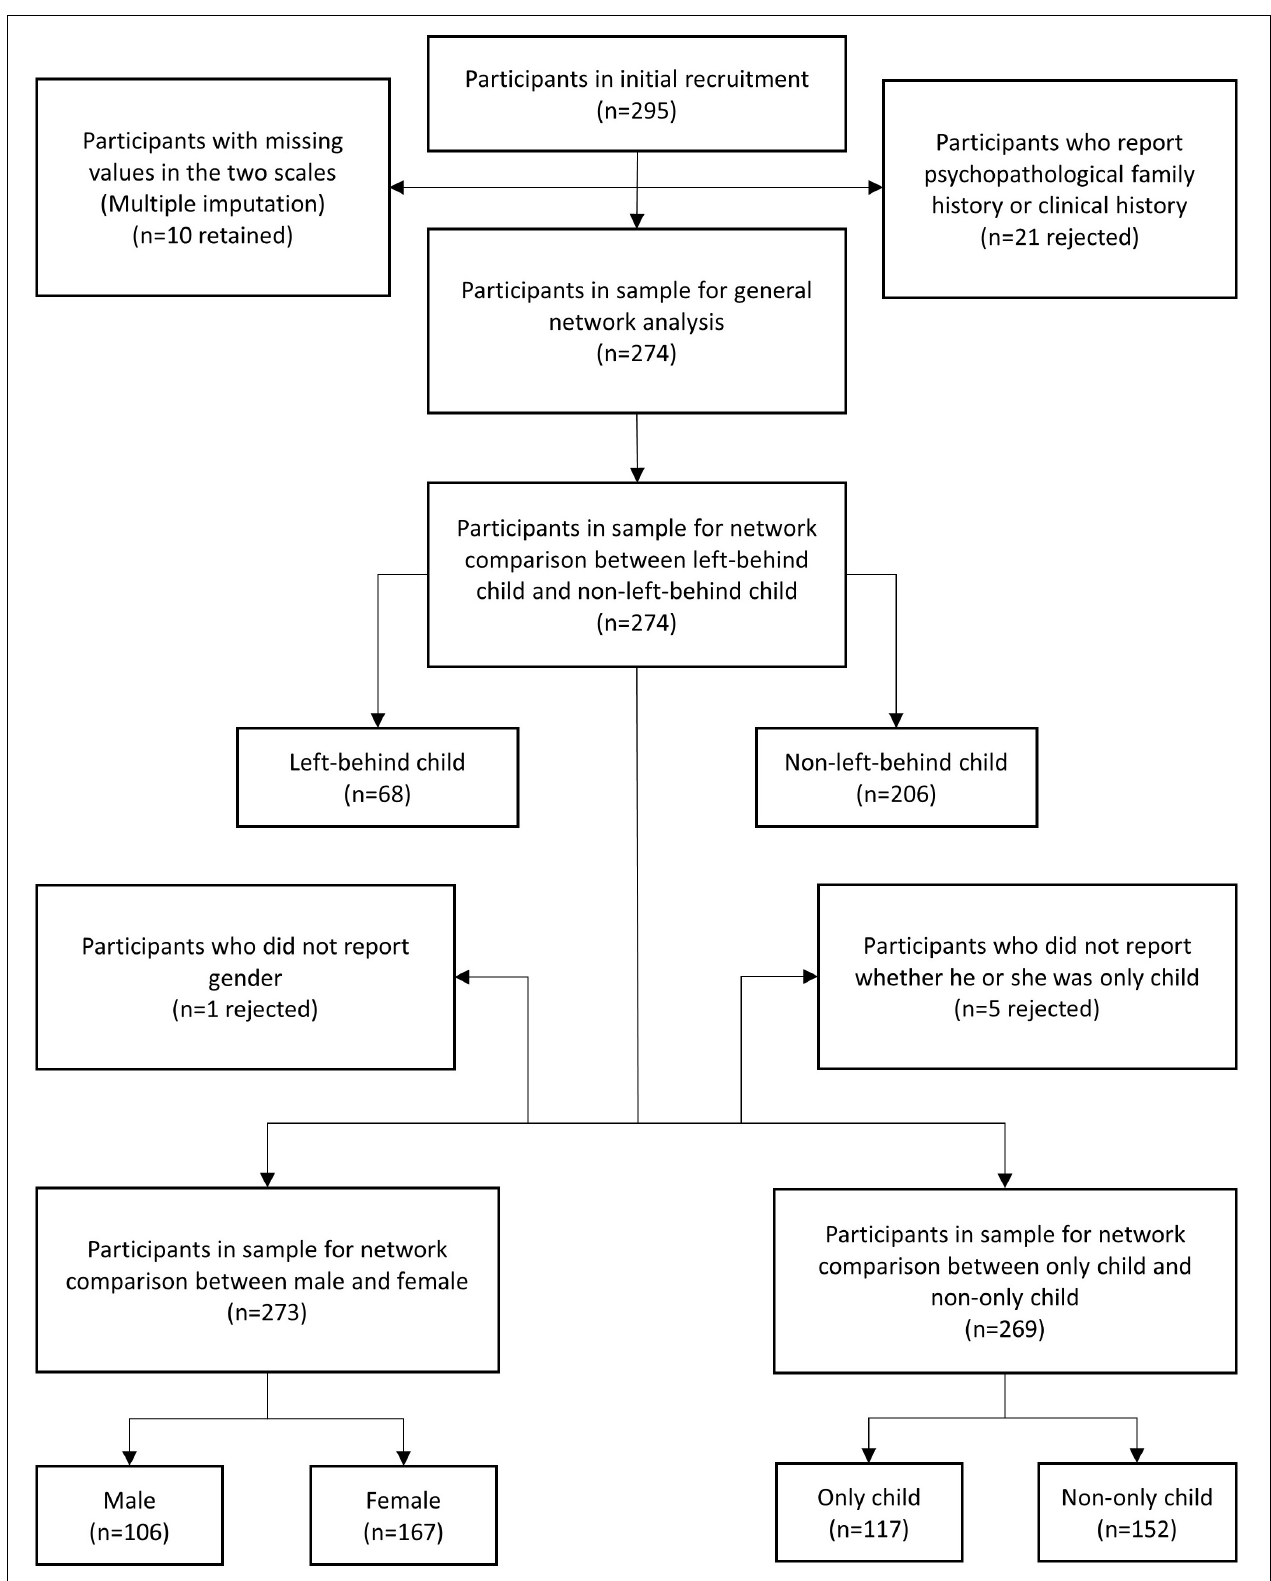
FIGURE 1 | The PRISMA diagram of the participants’ recruitment process. “ n ” represented the sample size.